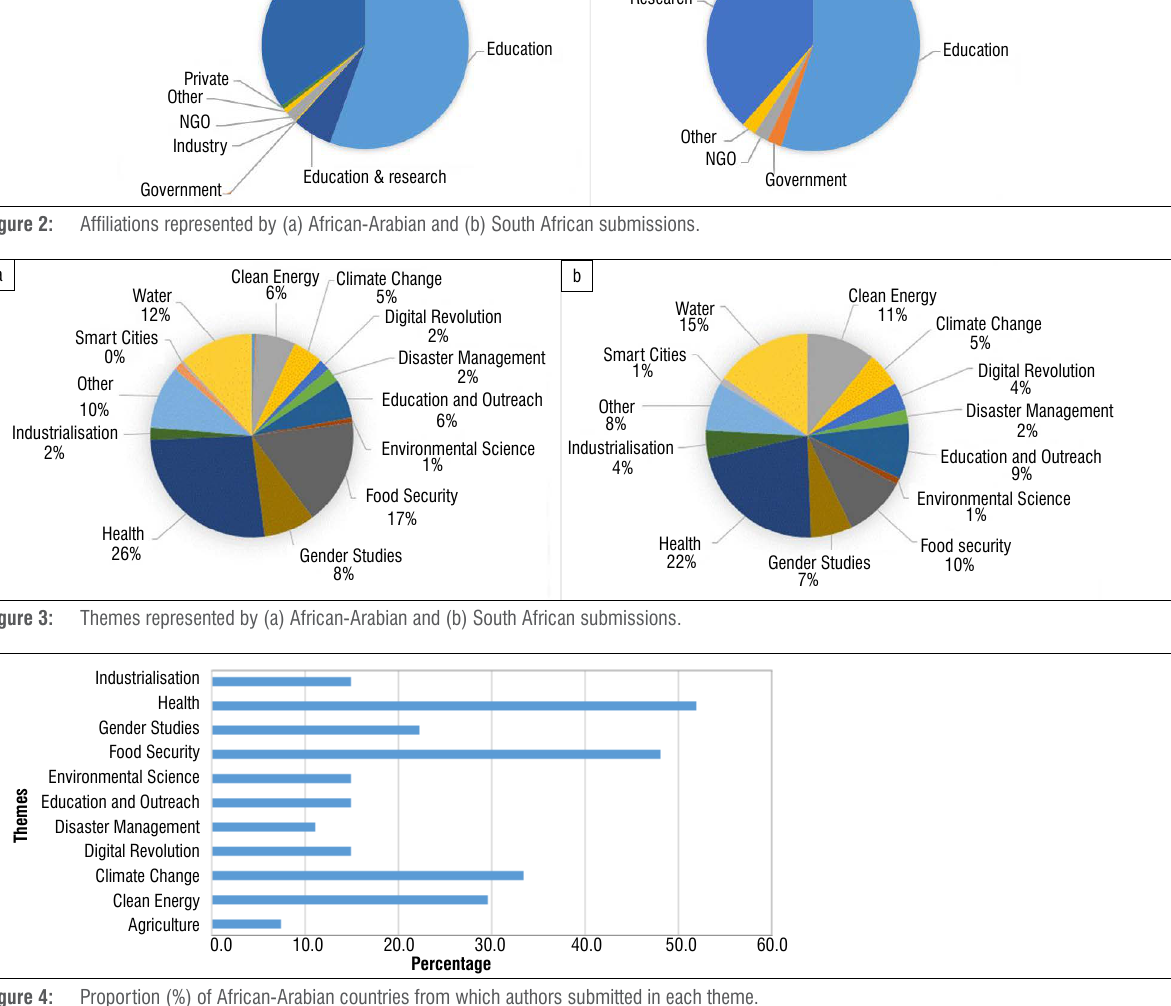
2 Volume 115| Number 3/4